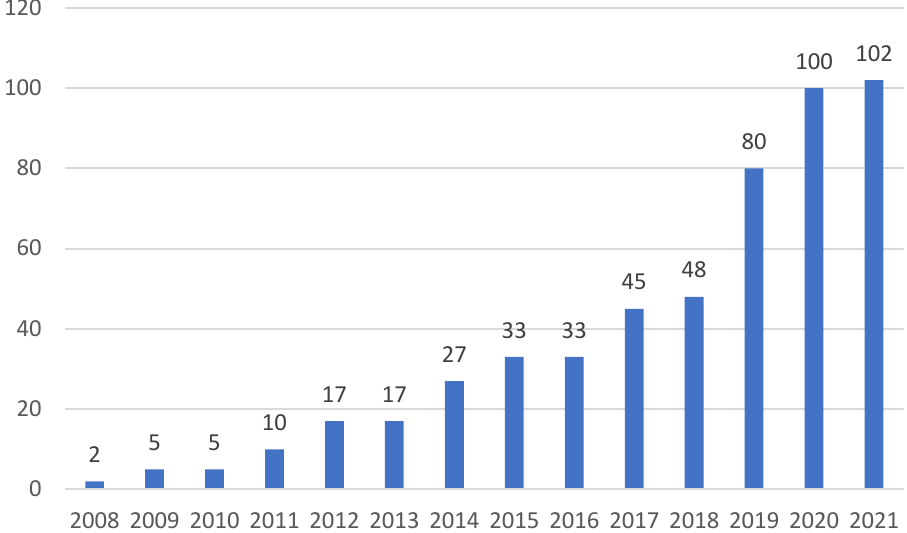
Figure 2. Number of articles published in each year on BIM in the field of carbon emissions within the context of sustainable buildings from 2008 to 2021 (14 years) in the Web of Science (WoS) core collection (generated by the authors).